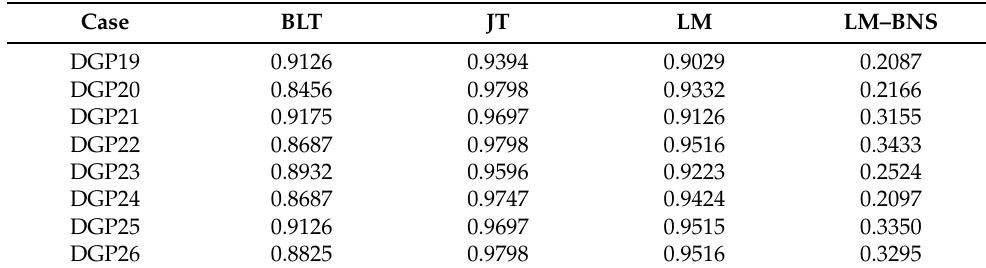
Table 6. Empirical power of co-jump tests under Monte Carlo simulations with co-jumps and idiosyncratic jumps